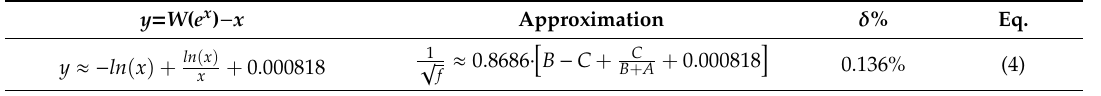
Table 1. A series expansion y of the W(e x ) − x and related approximation of the Colebrook equation based on it. y = W ( e x ) − x Approximation δ %